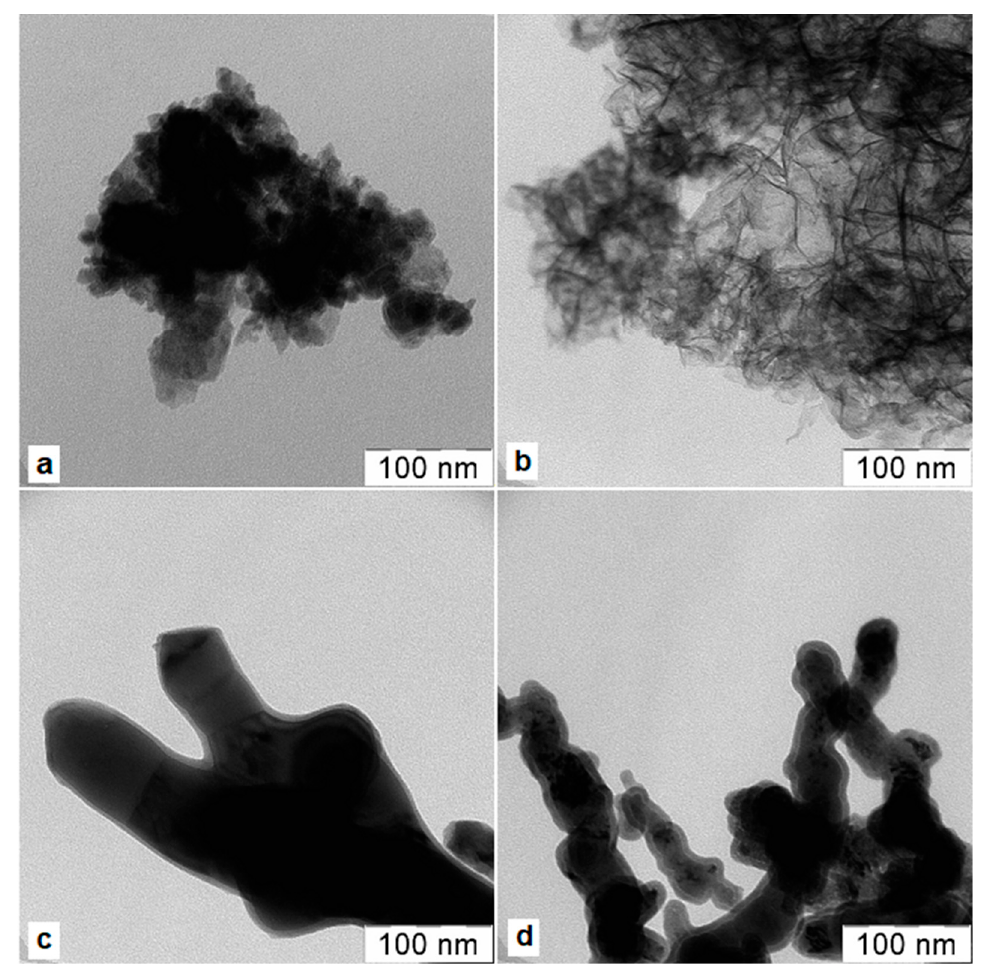
Figure 5. The transmission electron microscopy (TEM) images of nZVI produced from FeSO 4 ( a ), Fe(NO 3 ) 3 ( b ), FeCl 2 ( c ), FeCl 3 ( d ).